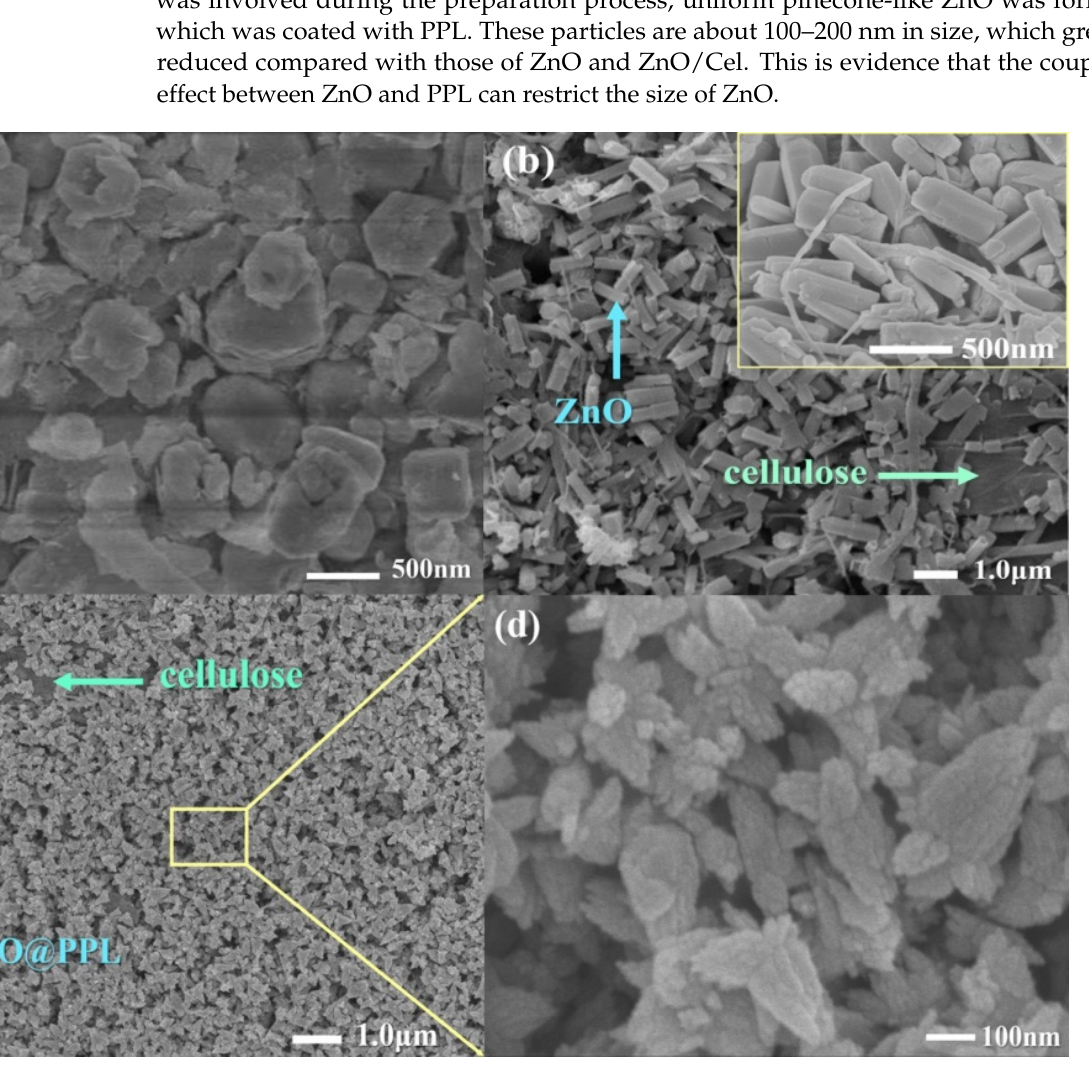
Figure 2. SEM images of ( a ) ZnO, ( b ) ZnO/Cel, ( c , d )